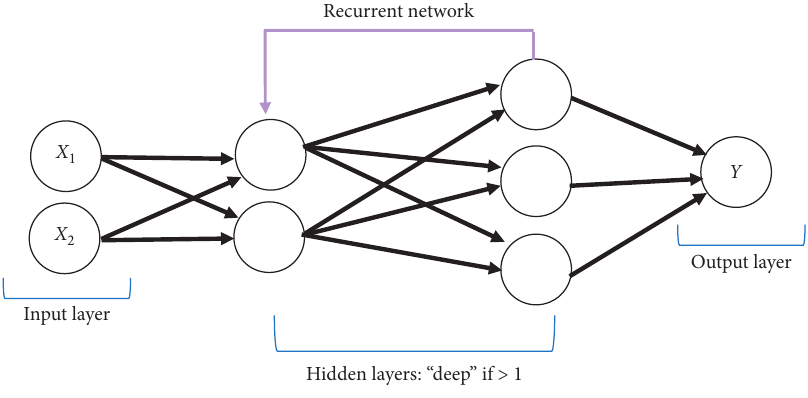
Figure 4: RNN architecture.